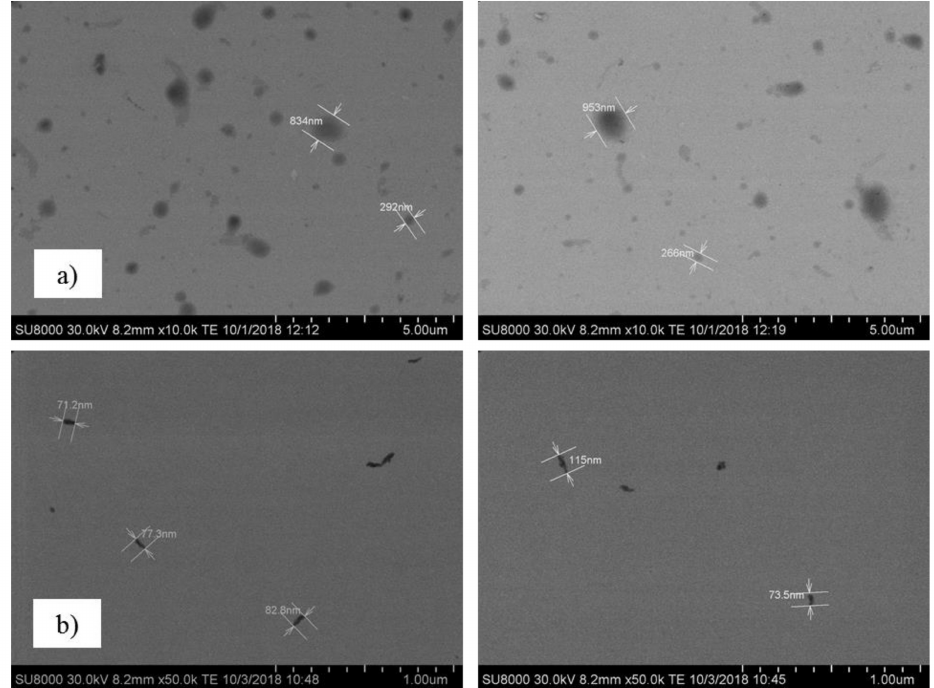
Figure 1. TEM images of the synthesized conductive polymers (CPs): ( a ) PANI and ( b ) PEDOT.